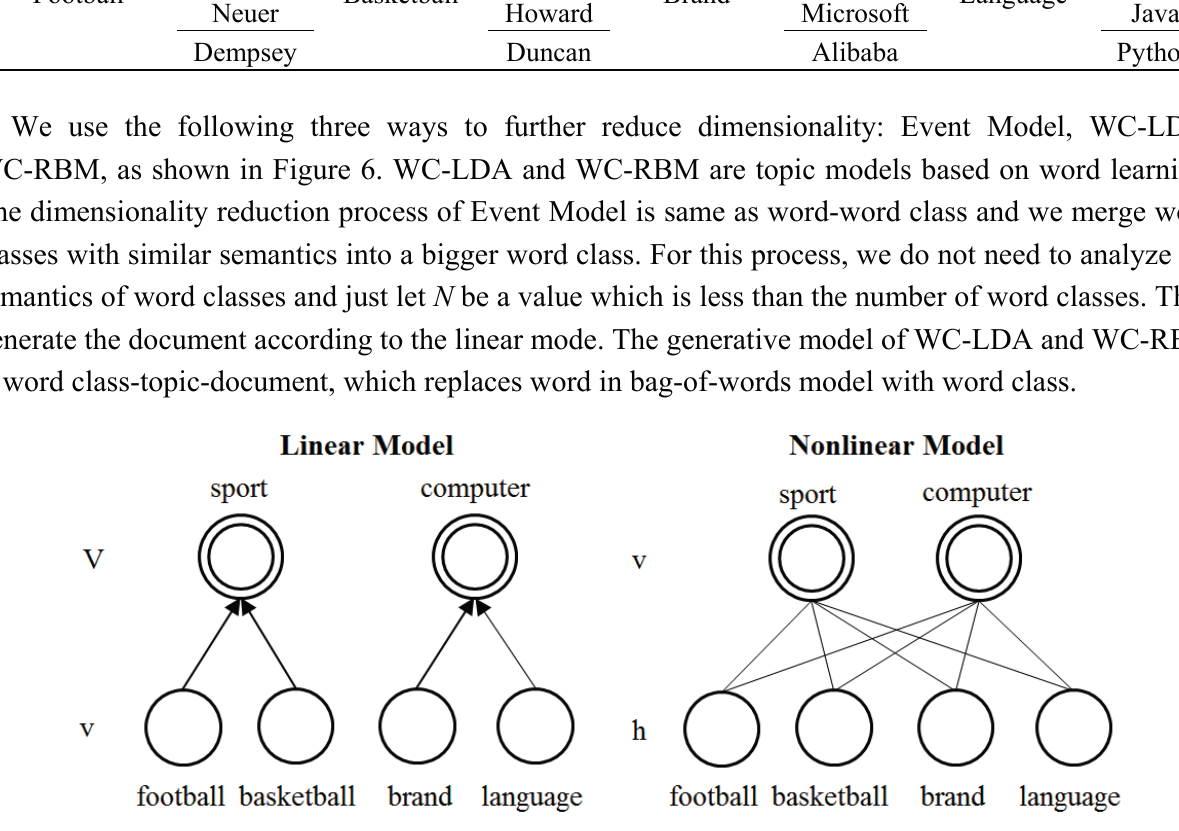
Figure 6. Left: The Relationship of V and v is linear. V (1) = v (1) + v (2), etc. Right: For WC-LDA, The Relationship of v and h is nonlinear, as shown in Equations